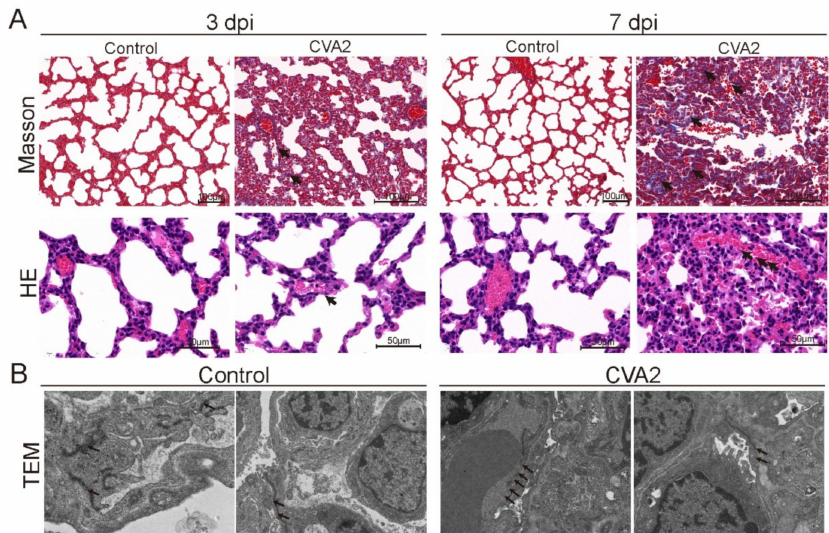
Figure 2. Histopathological changes of lung tissues after CVA2 infection. ( A ) Masson’s staining and HE were used to observe the pathological changes of lung tissue in mice at 3 dpi and 7 dpi. The black arrows indicate characteristic lesions. The alveoli collapsed, local pulmonary consolidation and diffused glial protein increase were observed in lungs of CVA2-infected mice. The infected lumens of alveoli were filled with edema fluid and red cells. No histological changes were observed in the lungs of uninfected mice. ( B ) The integrity of the pulmonary epithelium and morphological alterations of junctions was studied by TEM in both CVA2 infection and control groups. The arrows indicate tight junctions between endothelial cells. All experiments were repeated three